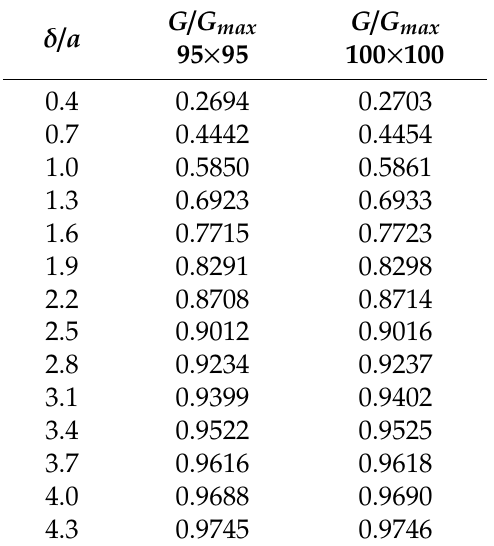
/ G G / G max max δ / a G 95 × 95 100 × 100